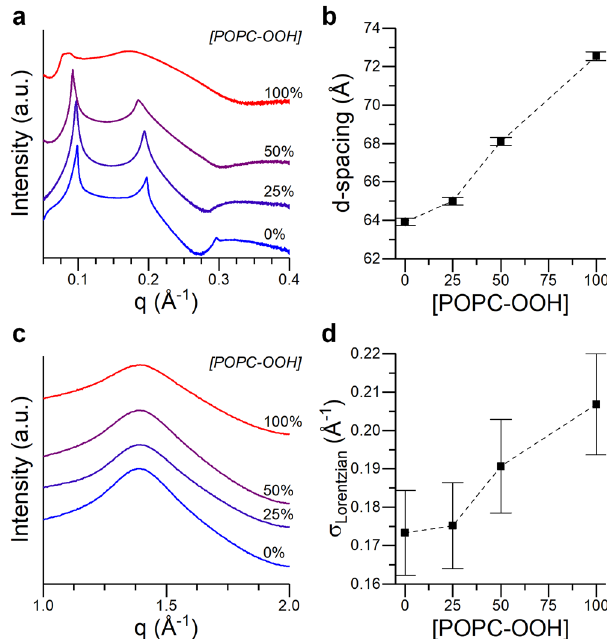
Fig. 4 X-Ray scattering intensity pro fi les for POPC/POPC-OOH bilayers. a , b SAXS pro fi le and interlamellar spacing calculated from the 1st Bragg peak. c , d WAXS traces and width of the fi tted Lorentzian component. Data shown as mean ± S.D. S.D. in POPC-OOH containing membranes was estimated according to the S.D. of pure POPC samples, see ESI for